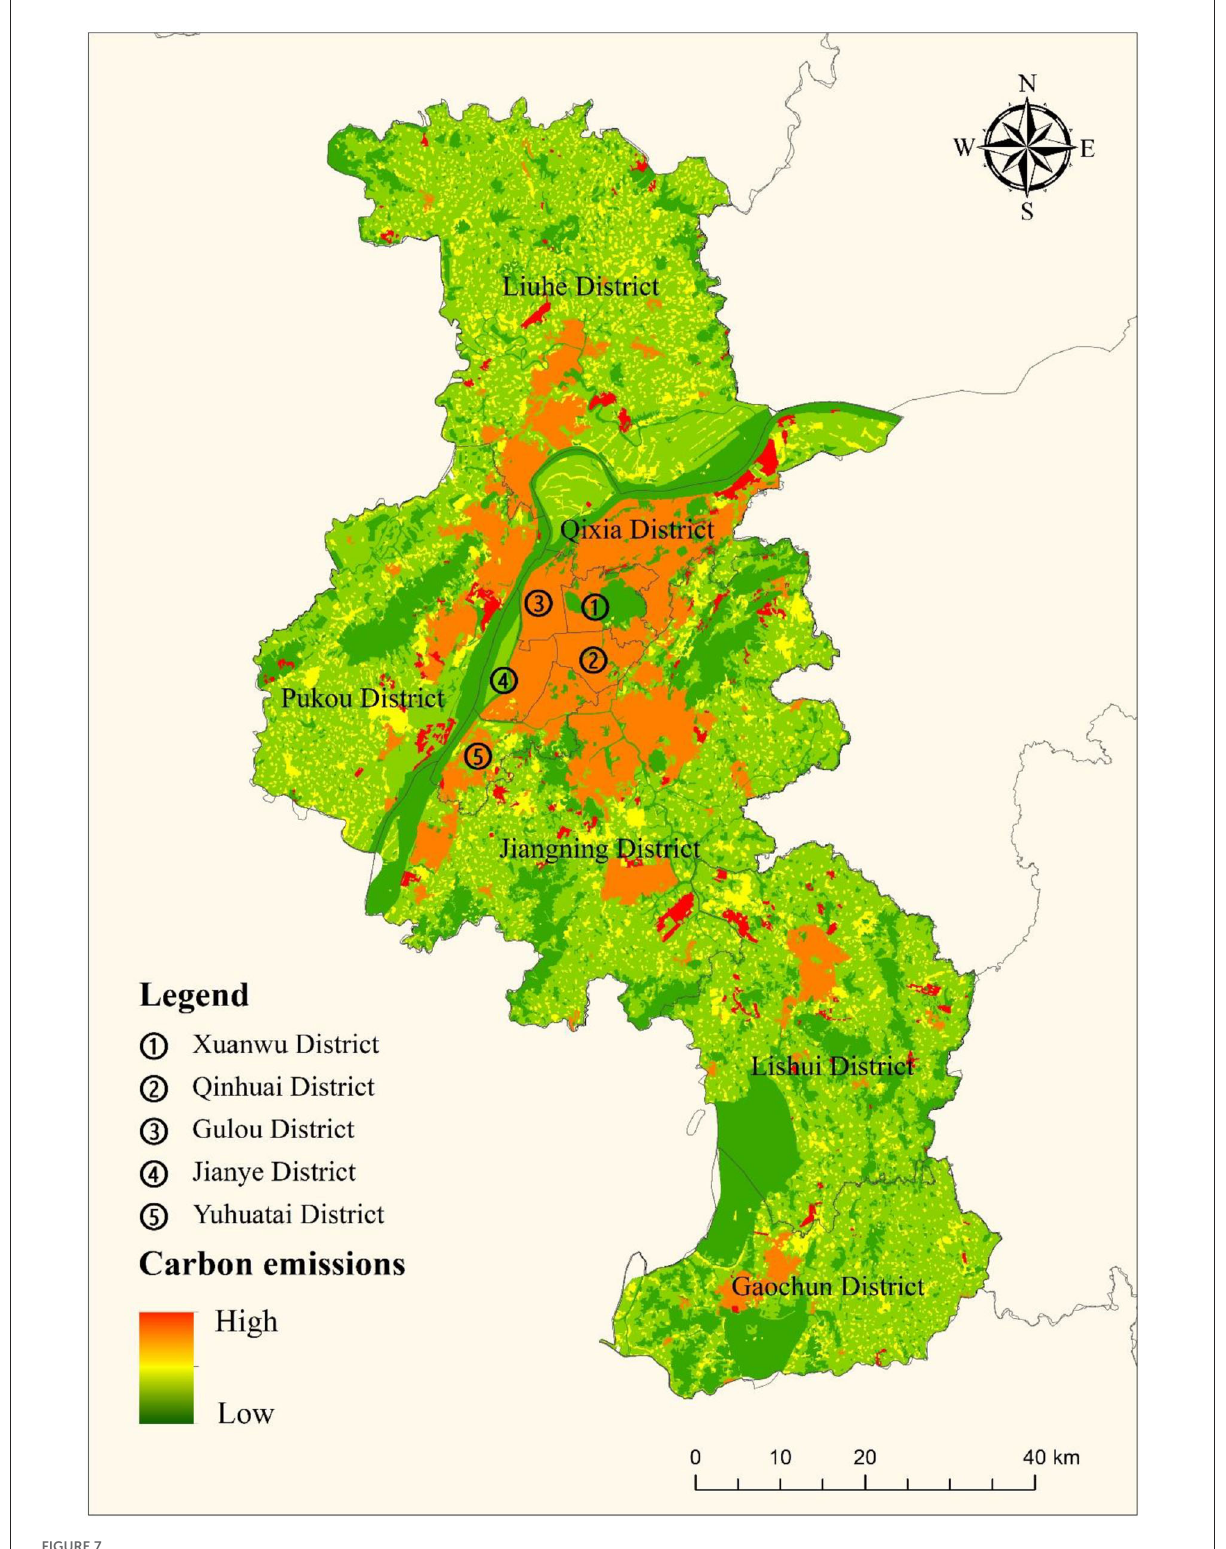
FIGURE7 Spatialization results of carbon emissions of Nanjing in